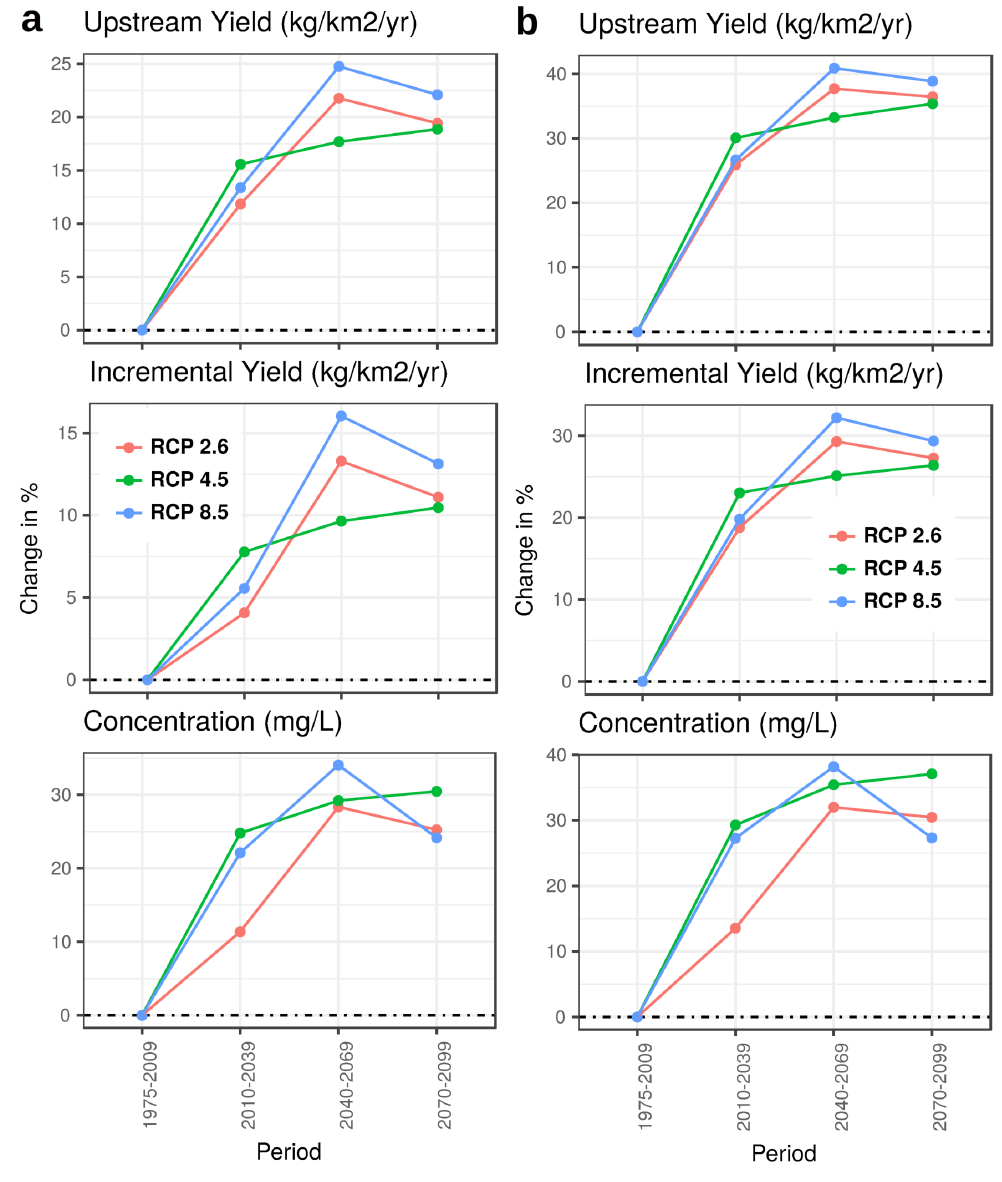
Figure 5. Percentage changes of upstream yield (kg km − 2 year − 1 ), incremental yield (kg km − 2 year − 1 ) and concentration (mg L − 1 ) for ( a ) TN and ( b ) TP stemming from GCM averages for each RCP and future periods. Percentages were estimated with respect to values for the reference period